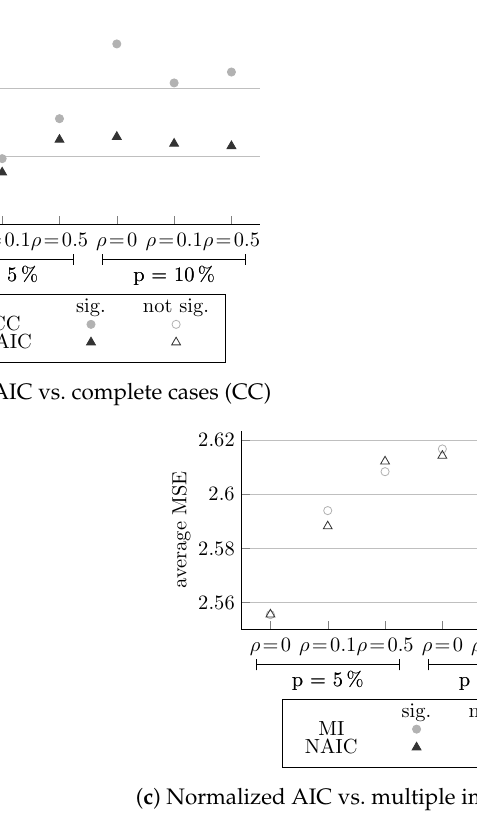
Figure 3. Comparing the MSE of normalized AIC (NAIC) and other methods, averaged over 100 simulations, and the significance of the